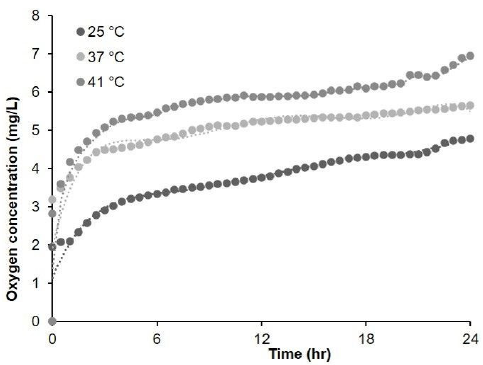
Figure 8. HAADF-STEM images of the MOLNBs decorated with SPIONs taken at different magnifications (( a ) = 500 nm, ( b ) = 200 nm, ( c ) = 20 nm).